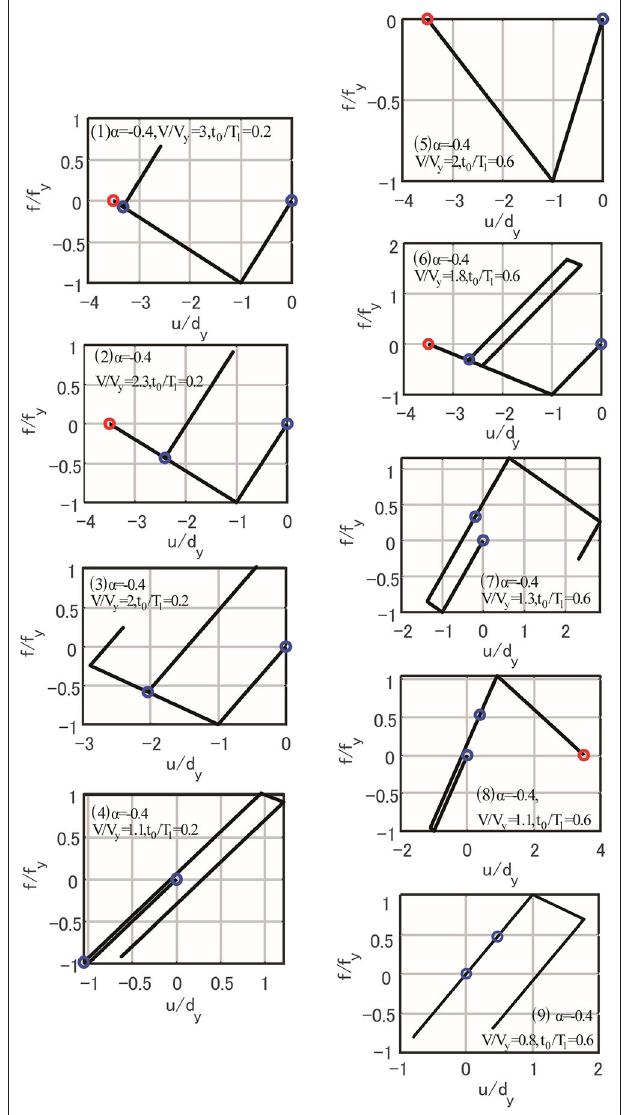
FIGURE 15 | Restoring-force characteristics corresponding to various combinations of impulse timing and input velocity level (blue marks indicate double impulse timings and red mark shows collapse